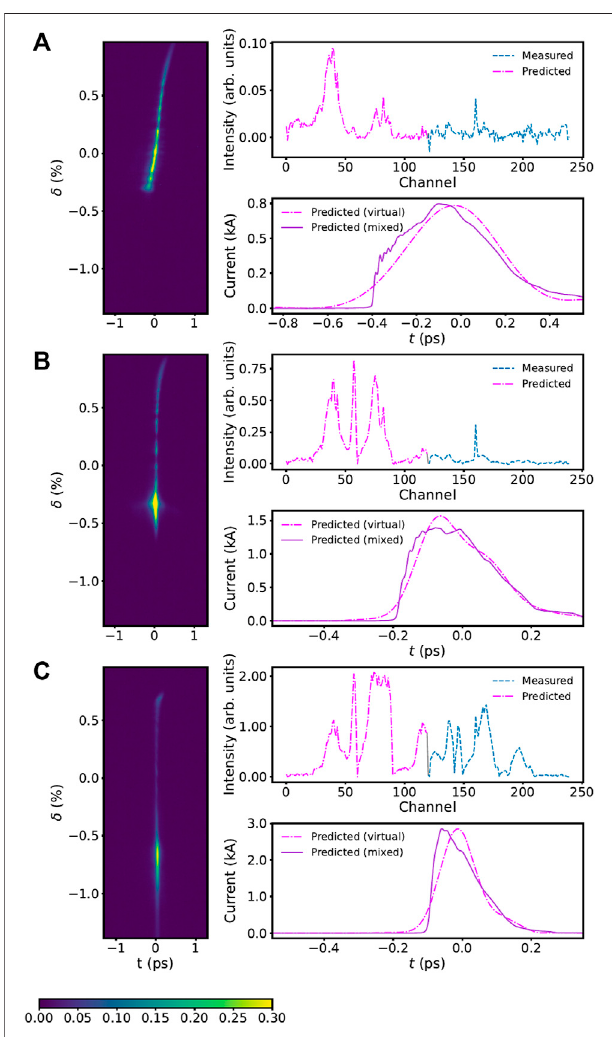
FIGURE 9 | Three typical results for mixed diagnostics with the CRISP spectrometer. The measured LPS image and the mixed spectrum are shown for each result. The current pro fi les reconstructed from the mixed spectra are compared with the current pro fi les reconstructed from only the predicted (virtual)